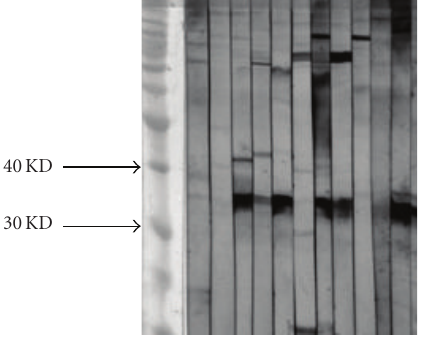
Figure 1: 12 purified anti-dsDNA antibodies from SLE patients. Seven of these purified antibodies can bind a 35 KD burkholderia fungorum bacterial protein in Western Blot.